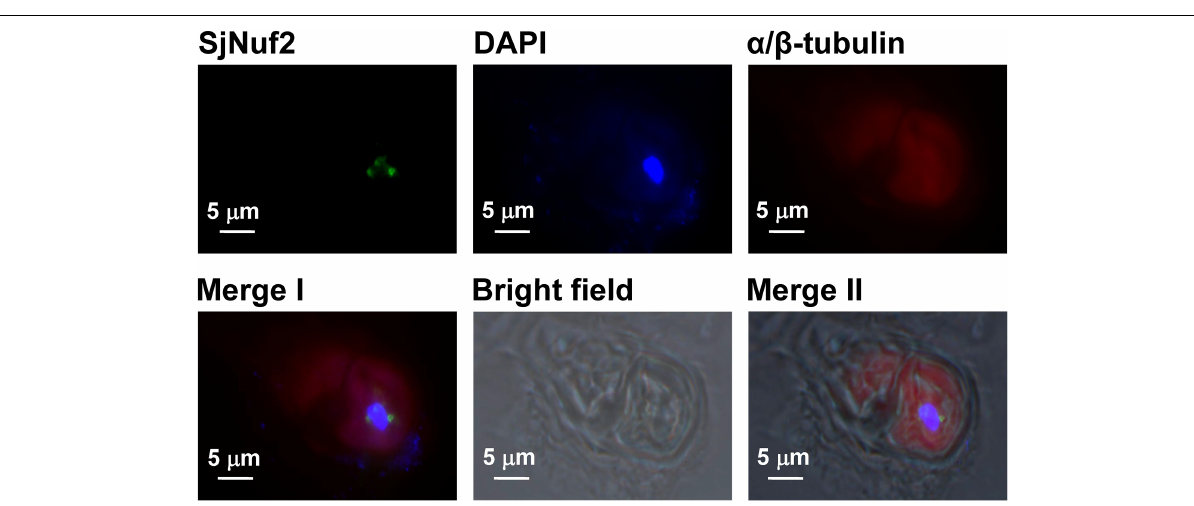
FIGURE 4 | Immunofluorescence images showing the tubulin cytoskeleton (red) and the localization of SjNuf2p (green) on the nuclei of Saccharina gametophytes counterstained with 4 (cid:48) ,6-diamidino-2-phenylindole (DAPI) (blue). Merge I image is merged by SjNuf2, DAPI, and α / β -tubulin ones, and it and the bright field one produce Merge II